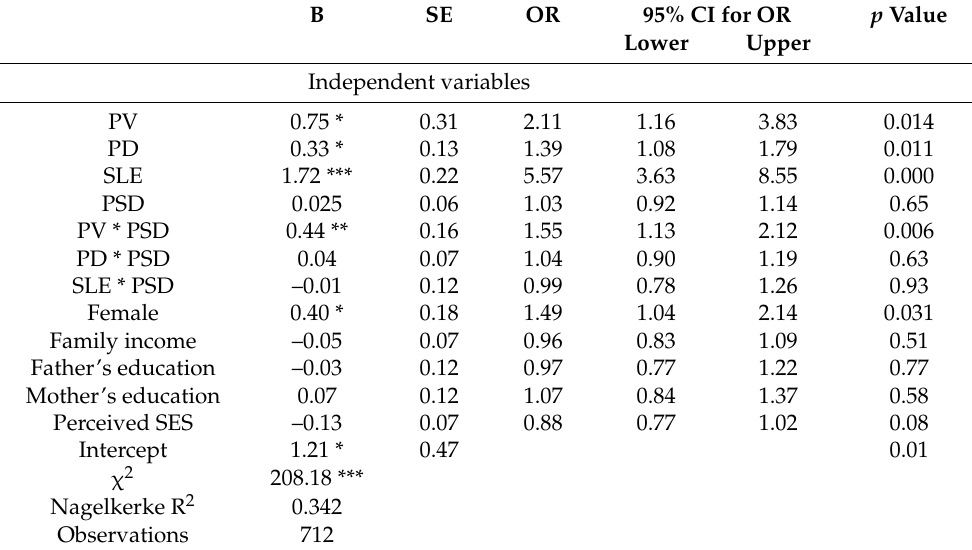
Table 3. Logistic regression estimates of risk factors and parental separation duration on depressive symptoms among left-behind children (LBC).